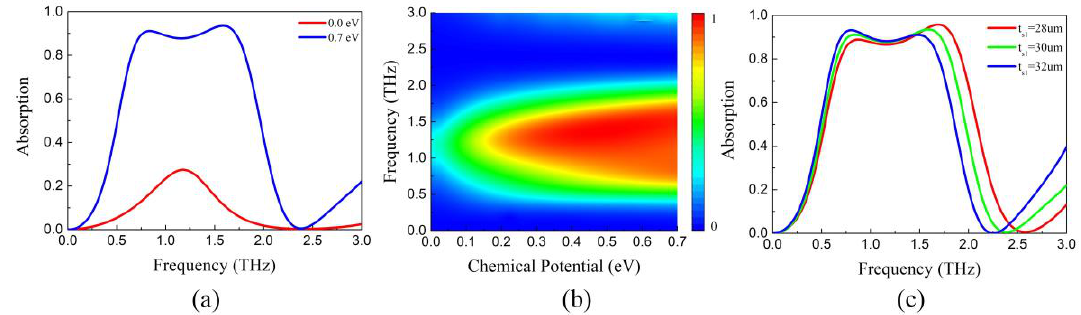
Figure 5. Absorption spectrum of the broadband absorption-controllable absorber ( a ) E F = 0 eV and 0.7 eV ( b ) As a function of frequency and E F ( c ) with different t s1 when E F = 0.7